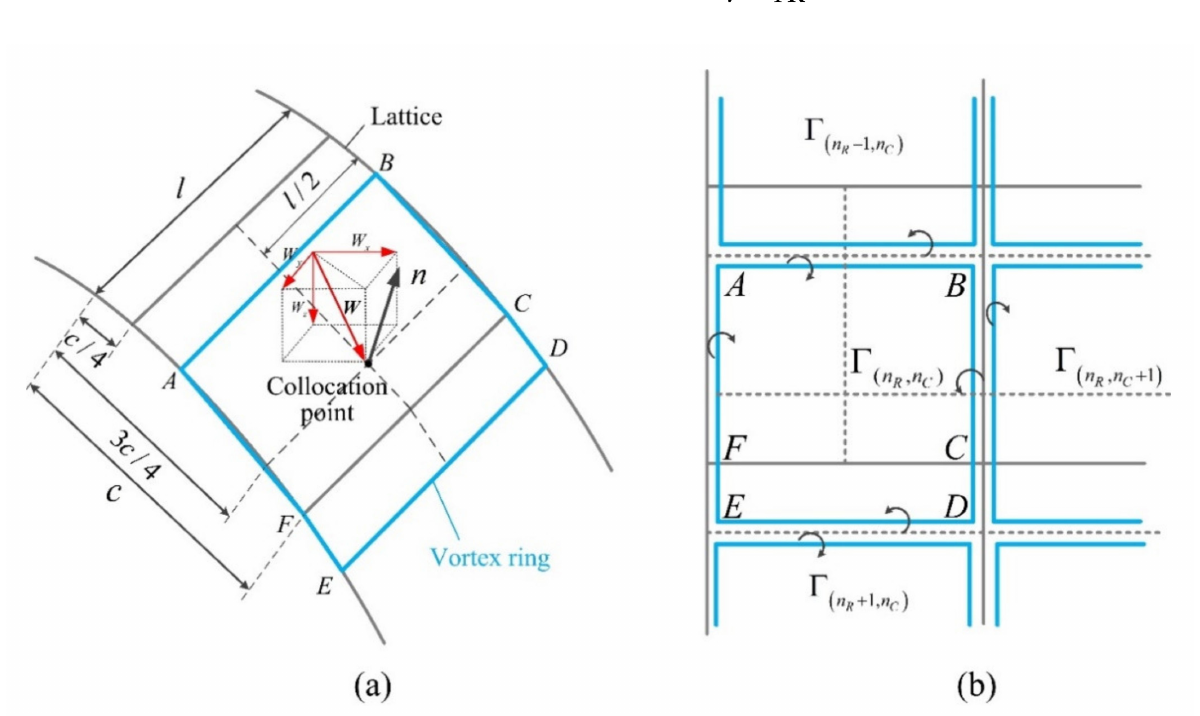
Figure 2. The vortex ring layout: ( a ) the vortex ring arrangement and wind speed components on collocation point. ( b ) the neighboring rings for a general vortex